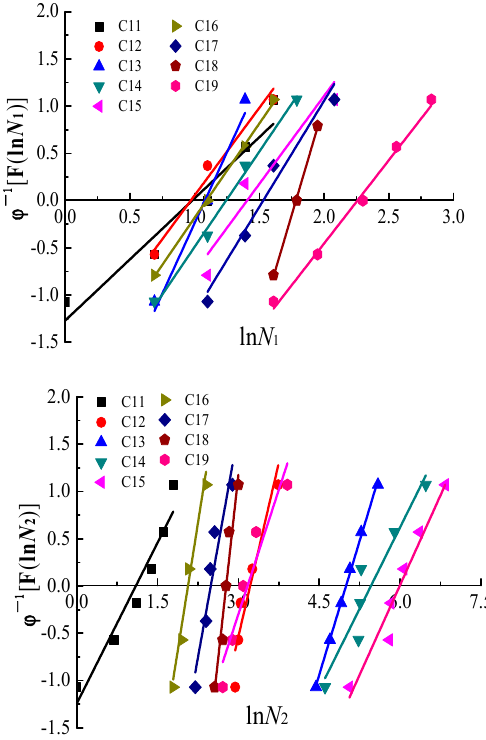
Figure 6. Linear regression of N 1 and N 2 in log-normal distribution for FRAC. Table 4. Linear fitting results of log-normal